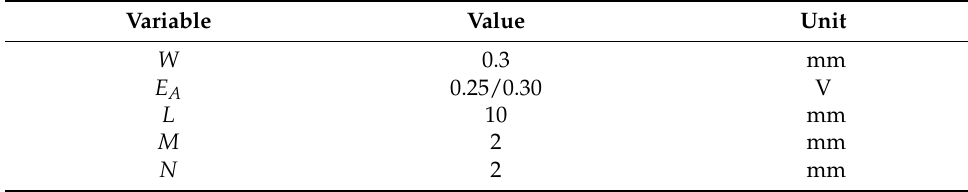
Table 1. Basic parameter values.